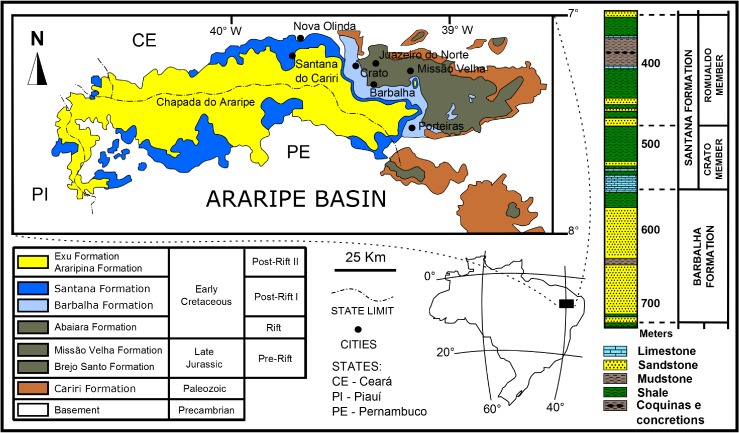
Araripe Basin locality and lithology.The Araripe Basin locality, the stratigraphic columns, units and chronology. (Adapted and modified from Coimbra, Arai & Carreño, 2002; Vianna & Neumann, 2002; Assine, 2007.)